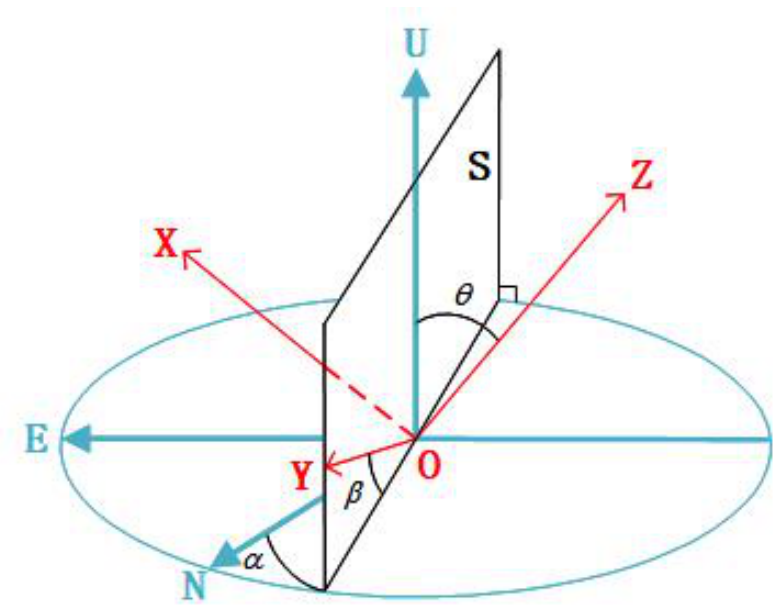
Figure 1. Schematic diagram of static Euler